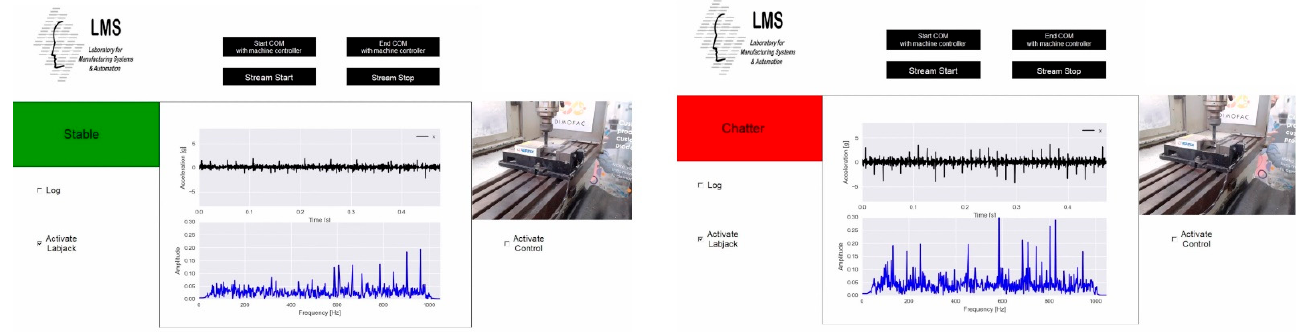
Figure 9. Snippet from the user interface of the chatter-detection system.